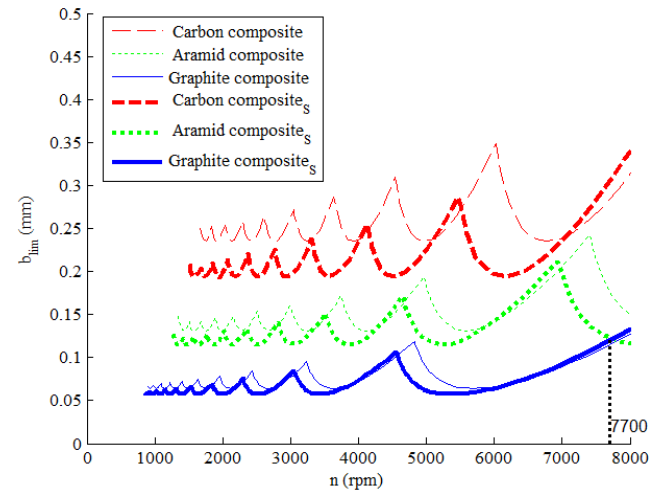
Figure 12. Chatter stability lobes of different composite boring bars.